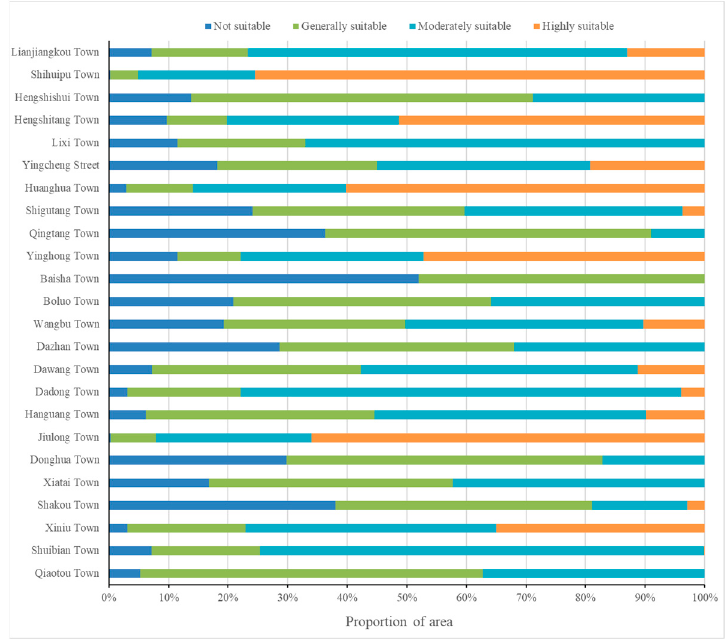
Figure 7. Tea cultivation suitability assessment by town. Table 8. The q-statistics on factors influencing land